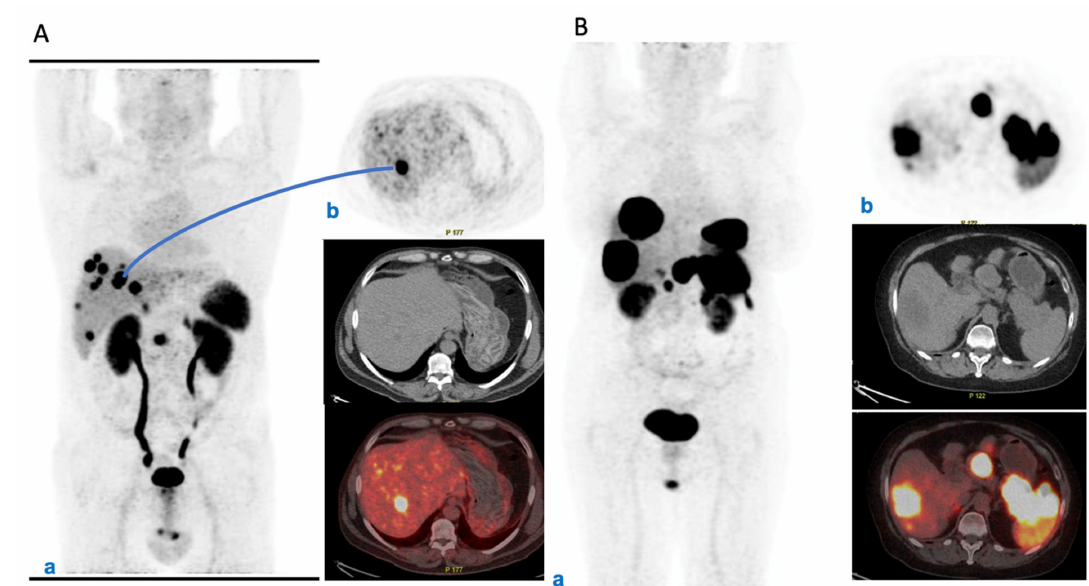
Figure 2. ( A ) PET/CT initial staging in metastatic pNET. (a) Male, 62 years old, pNEN, G1, initial staging. PET/CT 68 Ga-DOTATOC MIP: depicts the intense uptake within primary pancreatic NEN (SUVmax 16.6) and in multiple liver metastases (SUVmax range: 6.6-62). (b) Axial image of the hottest liver metastasis along with corresponding CT and fused slice. ( B ) Female, 68 years old, pNEN, G3, staging during therapy with SSA and FOLFIRI. PET/CT 68 Ga-DOTATOC MIP: (a) depicts the intense uptake within primary pancreatic NEN (SUVmax 38.6) and in large liver metastases (SUVmax range: 3-92). (b) Axial image of the primary pancreatic NEN, mesenteric lymph node, and largest liver